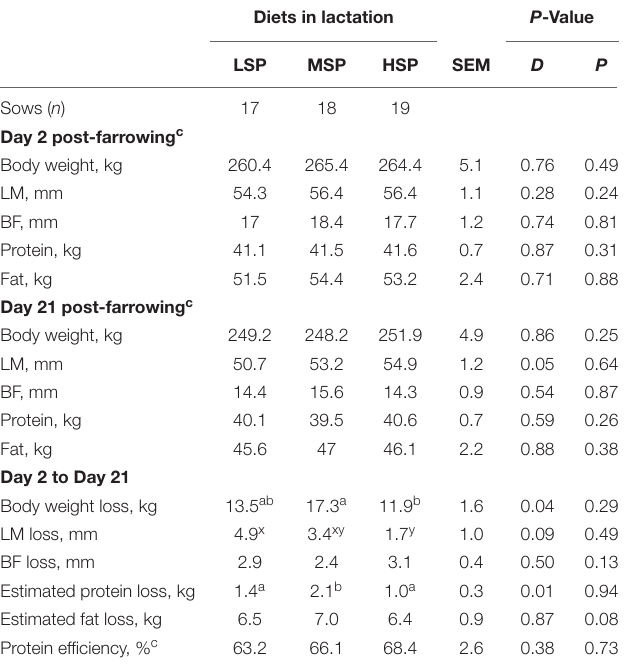
( Table 3 ; (cid:49) = 2.2 mm, p = 0.09). Estimated protein losses were highest in sows fed with MSP ( Table 3 ). Estimated fat loss and backfat loss, calculated protein and fat loss, and protein efficiency were not different among the dietary treatments ( Table 3 ).